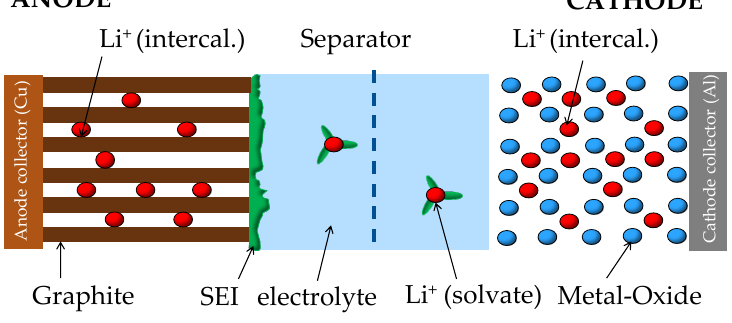
Figure 2. Schematic of a typical dual-intercalation LIB cell with graphite anode and metal-oxide type